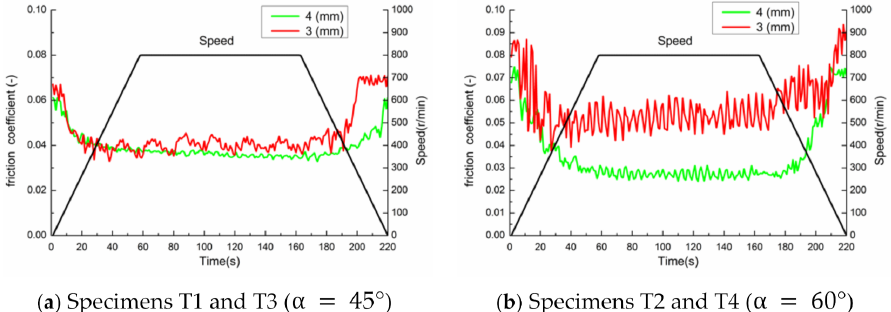
Figure 12. Friction coefficient curves of friction disks.